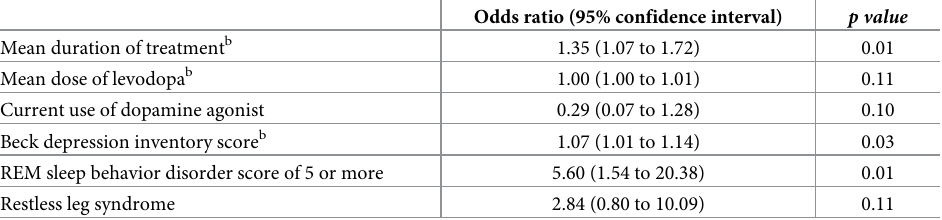
Table 3. Results of multivariable analysis a for factors associated with sleep-related hallucinations among patients with Parkinson’s